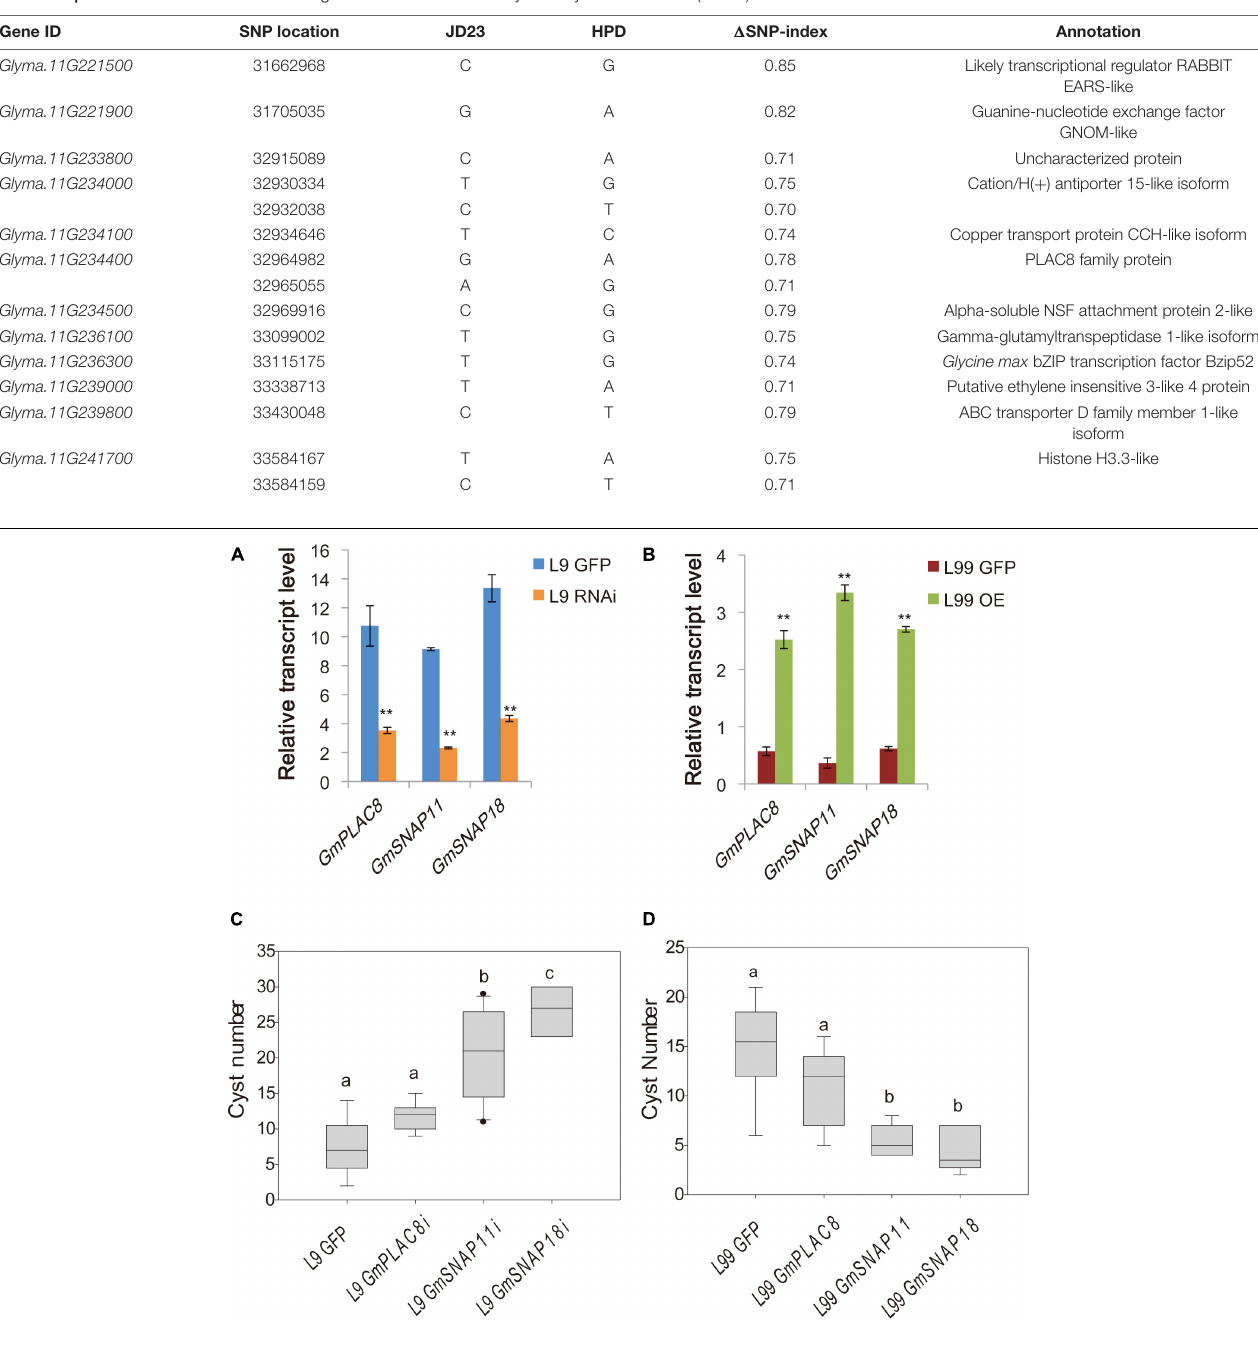
FIGURE 2 | Relative transcript levels and cyst counts in various lines. (A) Relative transcript levels in the RNAi and (B) overexpression lines. The mean and SE of nine samples are shown. ** represents a significant difference at P < 0.01. (C) Cyst counts in soybean cyst nematode 4 (SCN4)-resistant RIL L9 ( rhg1 + , Rhg4 + , rhg1-paralog + ) with suppressed expression (RNAi) of these genes and (D) SCN4-susceptible RIL L99 ( rhg1 + , Rhg4 + , rhg1-paralog - ) overexpressing these genes. The different letters above the boxes represent different significant levels at P < 0.05.